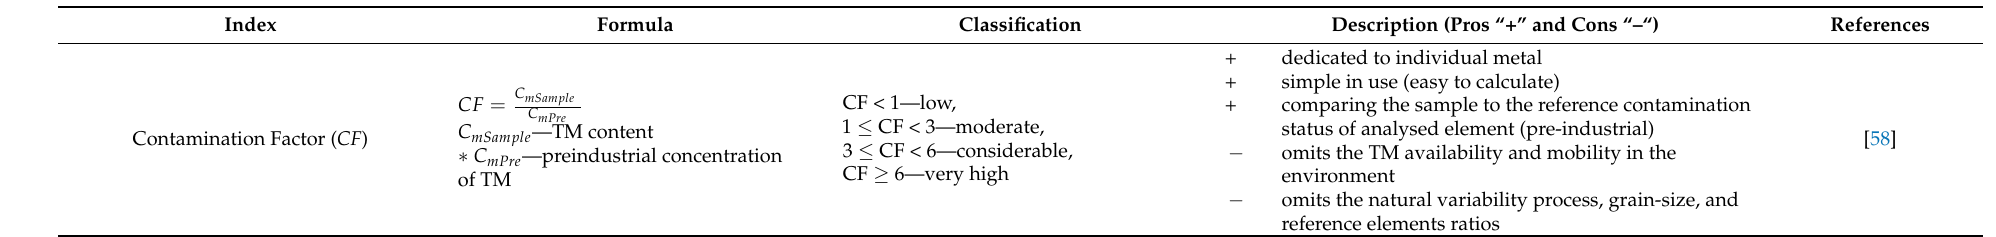
Table A2. A list of Individual (single) Pollution Indices (IPIs) given in the literature with classification and a basic description of strengths and